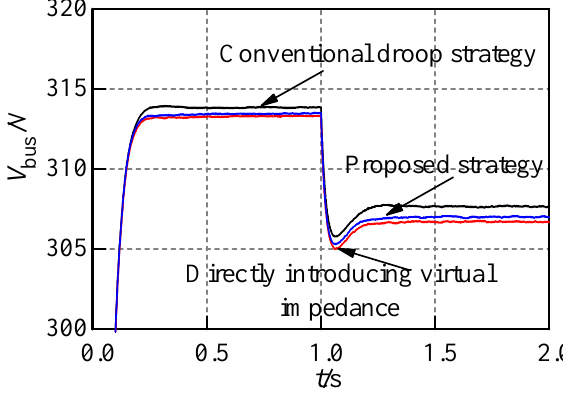
Figure 14. Microgrid AC bus voltage.